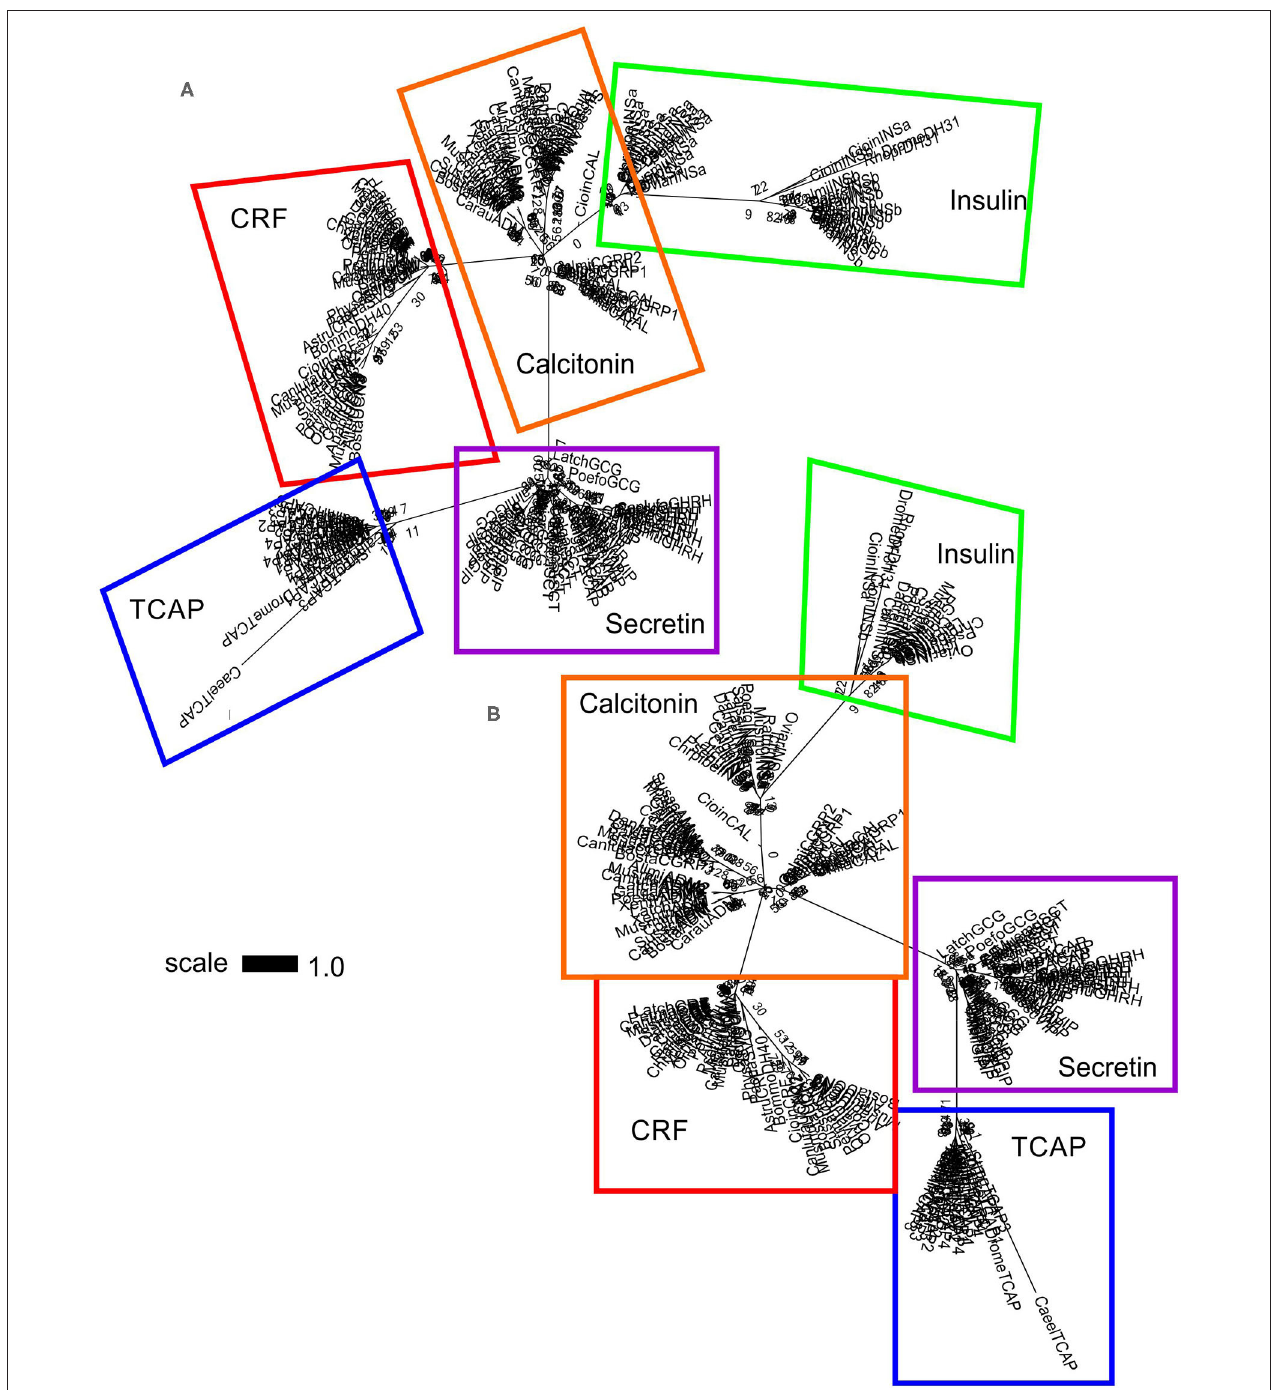
FIGURE 6 | Phylogenetic analysis of insulin, calcitonin, CRF, secretin, and TCAP mature peptides. The trees are represented as (A) unrooted and (B) rooted to TCAP. Each family is highlighted with a different color: CRF (red), calcitonin (orange), insulin (green), secretin (purple), and TCAP (blue). Analysis was conducted using the maximum likelihood method based on the Whelan and Goldman model (lnL = − 1781.0007; + G, parameter = 23.5912) (41). Initial trees for the heuristic search were obtained by applying the NJ method to a matrix of pairwise distances estimated using a JTT model. Branch lengths represent the number of substitutions per site, with the tree shown to scale. Bootstrap analysis involved 1,000 replicates. Calcitonin family: CALC, calcitonin; CGRP1, calcitonin-gene-related peptide 1; CGRP2, calcitonin-gene-related peptide 2; AM, amylin; ADM, adrenomedullin; ADM2, adrenomedullin 2; INSa, insulin A chain; INSb, insulin B chain; CRF family: CRF, corticotropin-releasing factor; TCN, teleocortin; UCN, urocortin; UCN2, urocortin 2; UCN3, urocortin 3; UI, urotensin; SVG, sauvagine; DH, diuretic hormone; Secretin family: SCT, secretin; GHRH, growth hormone releasing hormone; GIP, gastric inhibitory peptide; GCG, glucagon; PACAP, pituitary adenylate cyclase-activating peptide; VIP, vasoactive intestinal peptide; Outgroup: TCAP, teneurin C-terminal associated peptide. The scale bar indicates the level of magnification for the tree.